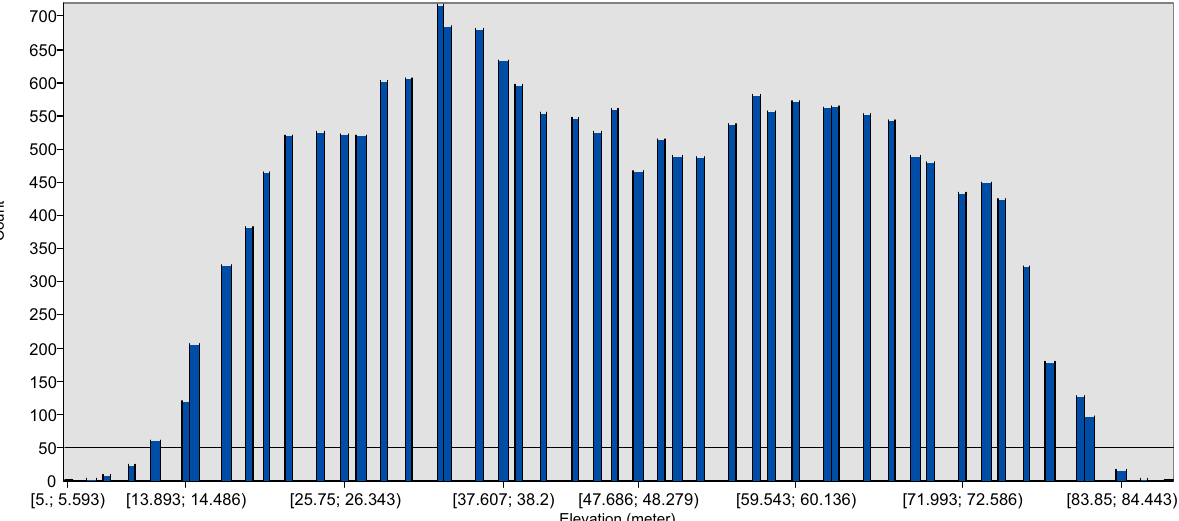
Figure 4. The histogram of the study area